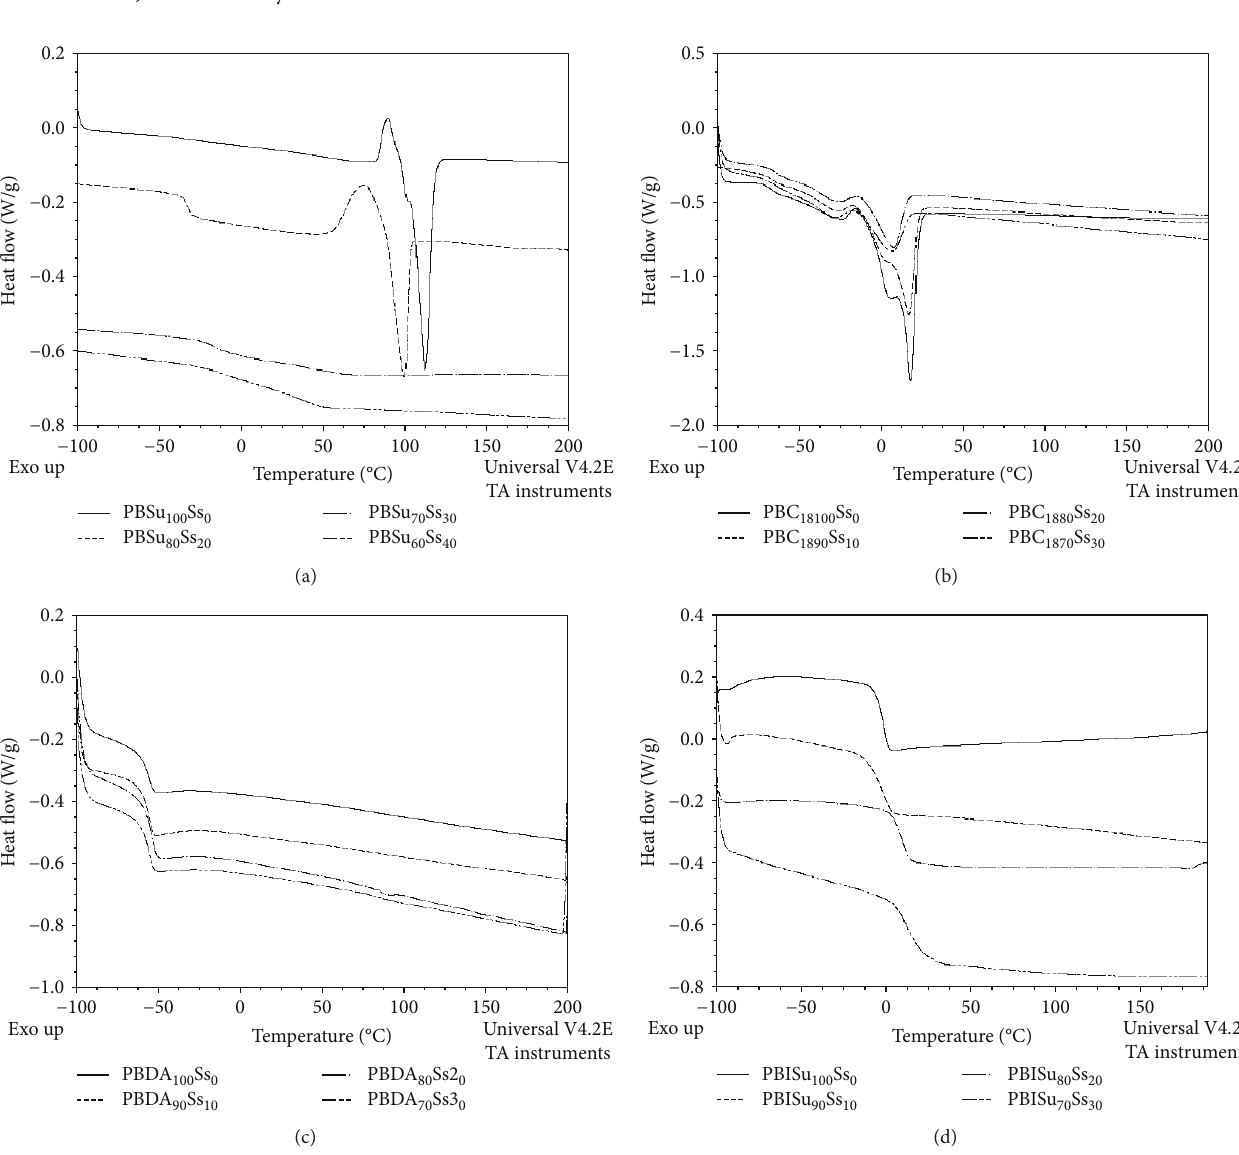
Ss , (b) DSC curves of PBC18 x y